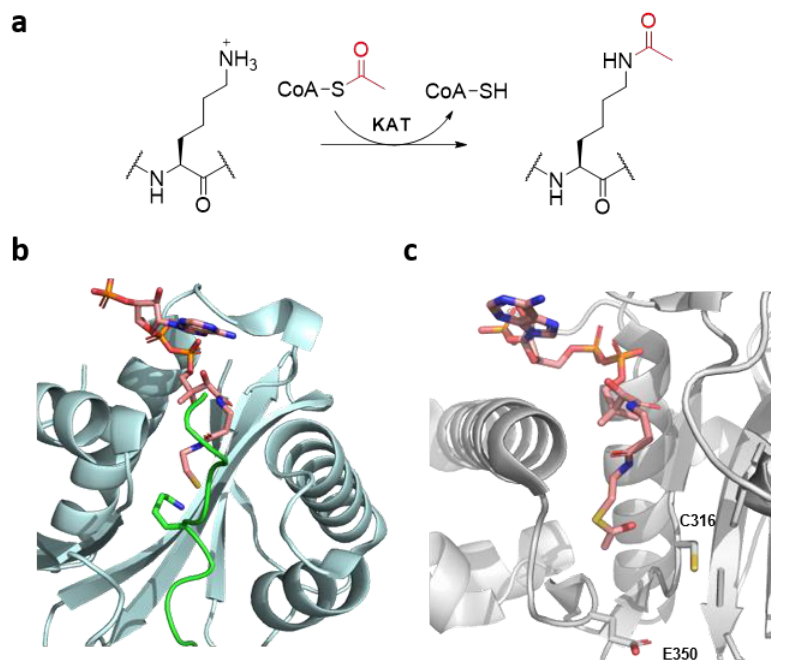
Figure 1. ( a ) Histone lysine acetylation by histone lysine acetyltransferases (KATs). ( b ) View of the crystal structure of the tKAT2A-H3K14-CoASH complex (tKAT2A: cyan; CoASH: pink; H3K14: green) (PDB: 1QSN). ( c ) View of the crystal structure of the KAT8-AcCoA complex (KAT8: gray; AcCoA: pink) (PDB: 2GIV), highlighting the two catalytically relevant residues C316 and